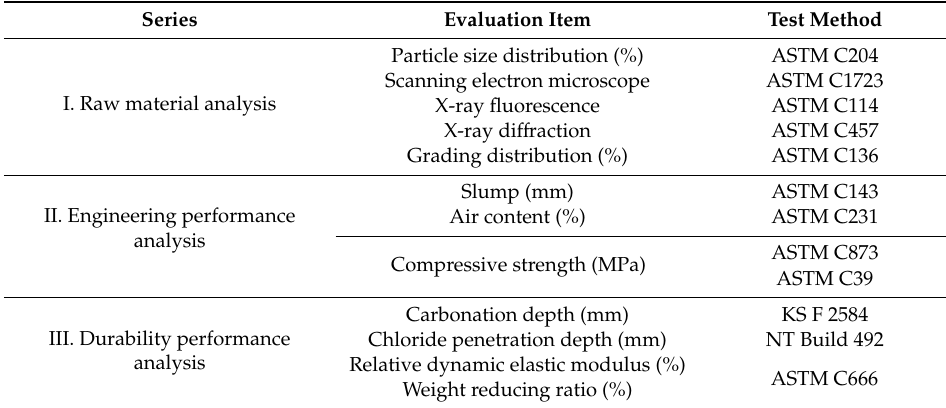
Table 5. Test methods by evaluation items.